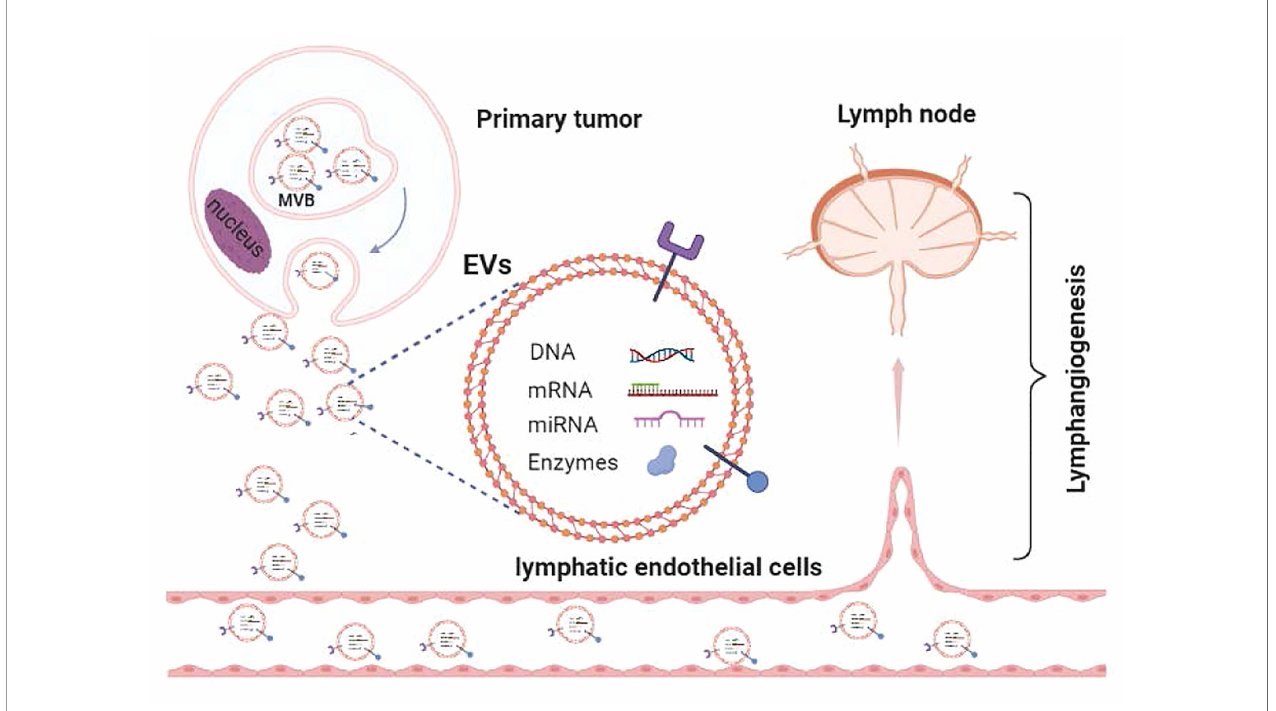
FIGURE 2 | The role of EVs in regulating lymph node pre-metastatic niche formation in HNSCC. (P.S. Created with